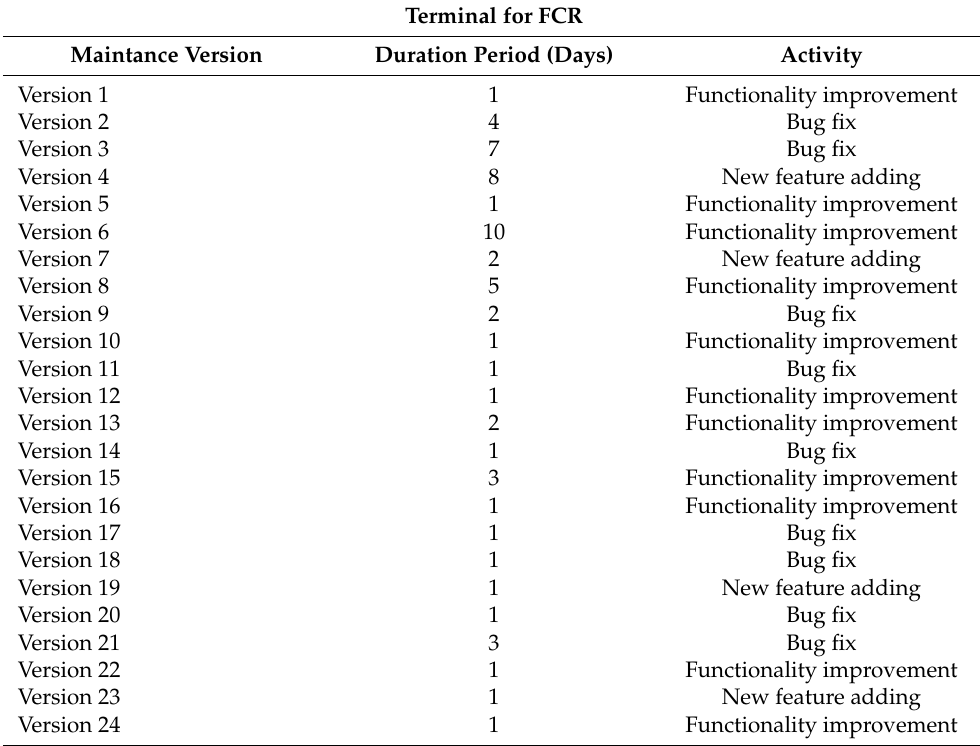
Table 2. The results of applying model-driven development method to the terminal for remote control of fiscal cash registers during the maintenance period for each version of the software.